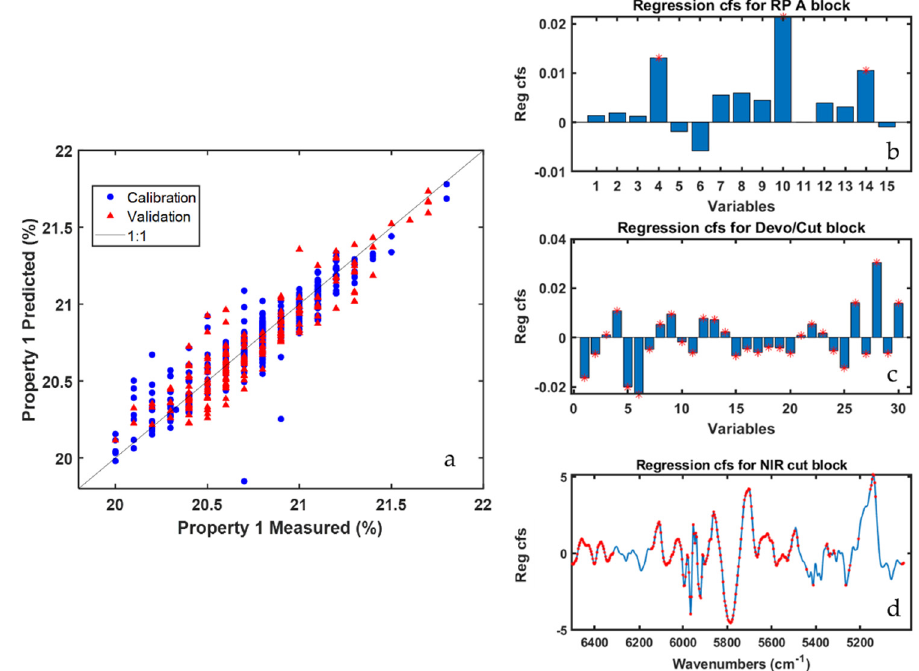
Figure 3. ROSA results for Property 1 prediction (all data blocks were modelled simultaneously). Predicted vs. measured value plot ( a ); regression coefficients for the RP-A ( b ); Devo/cut ( c ); and NIR cut ( d ) data blocks. Red stars indicate variables having VIP scores higher than one.